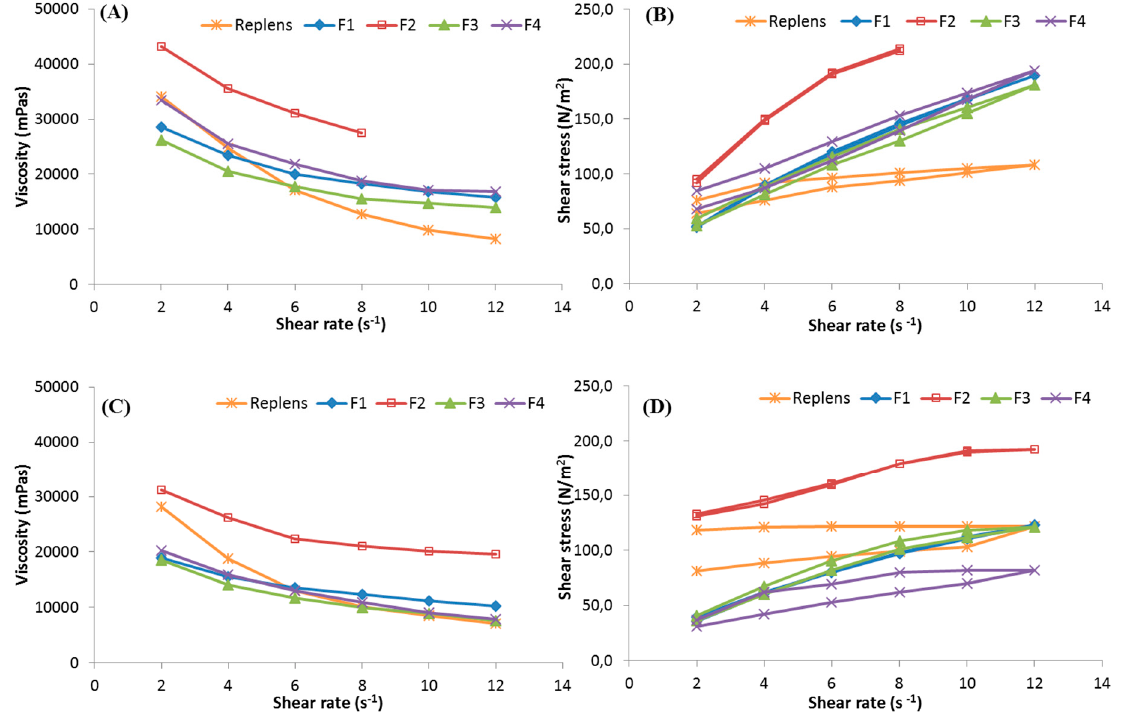
Figure 3. Influence of the shear rate on the rheological curves of unmodified CS (F1, F2), β -GP crosslinked CS hydrogels (F3, F4) and Replens™ measured at 25 °C ( A ) and 37 °C ( C ); The relationship between shear stress and shear rate of unmodified CS, CS/ β -GP hydrogels and Replens™ (mean ± S.D.; n = 3) measured at 25 °C ( B ) and 37 °C ( D ).